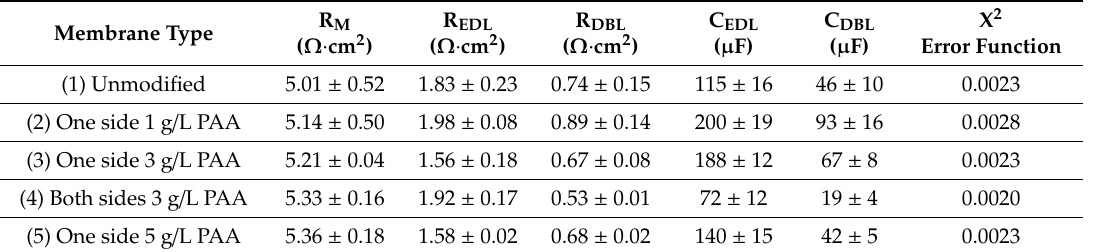
Table 5. AEM electro-resistances, electric double-layer, and diffusion boundary layer effects in 0.5 M NaCl aqueous solutions, measured through equivalent circuit model tool.